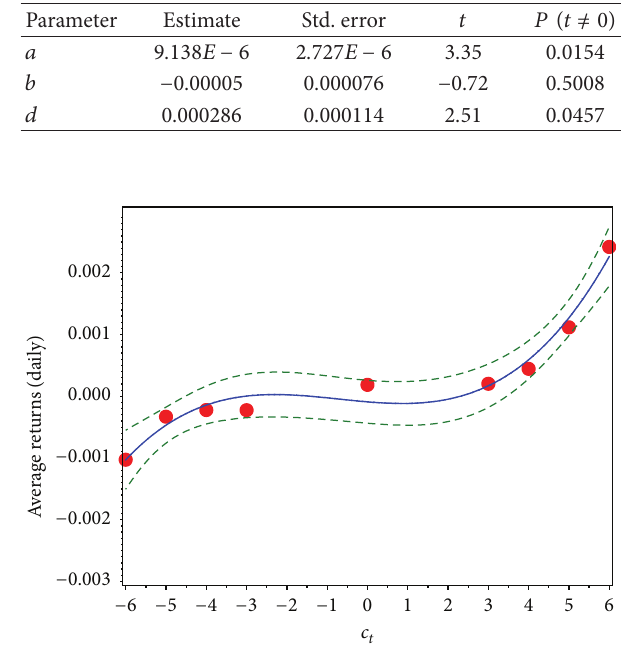
Figure 2: Relationshipbetween theproxy variable ofexcess demand ( 𝑐 𝑡 ) and the average daily returns on the US Treasury 30 years’ bonds (red dots: observation period 1993–2008). 𝑐 𝑡 is calculated on data of an NYSE stock